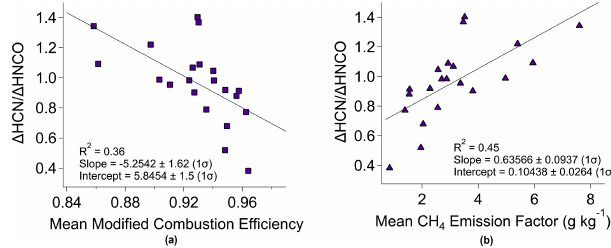
Figure 8. Plot of HCN enhancement over HNCO enhancement in biomass burning plumes vs. (a) mean modified combustion effi- ciency and (b) mean methane EF in grams per kilogram for all MOYA-II